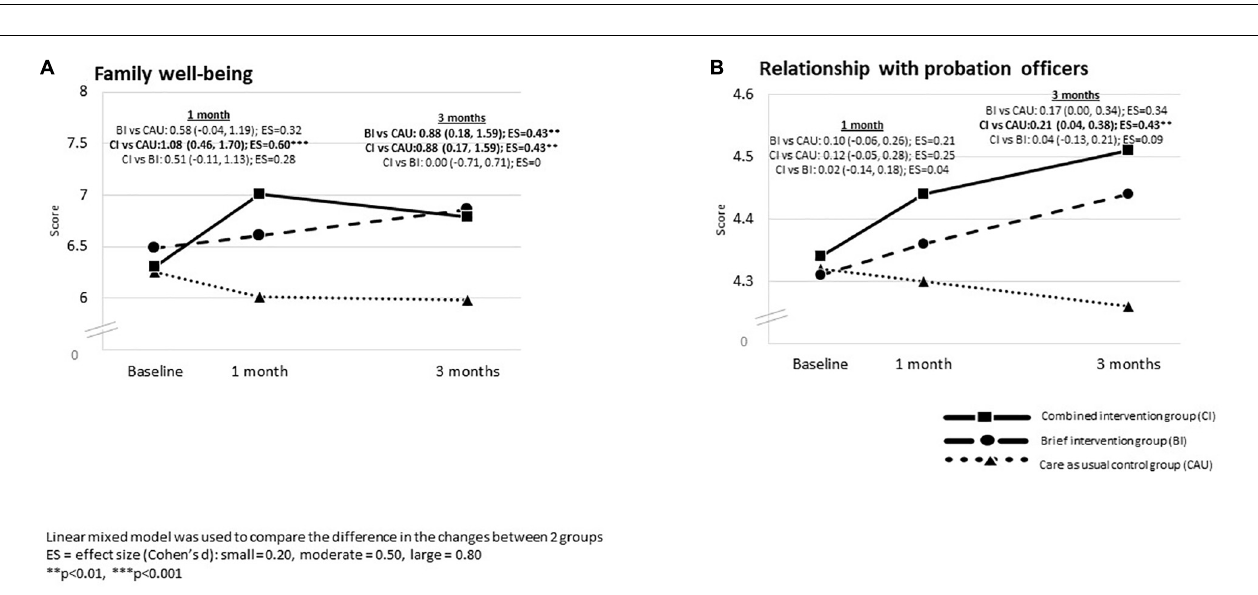
FIGURE 4 | The between–group difference in the changes in family communication at 1- and 3-month follow-up in three groups: Intention-to-treat analysis.